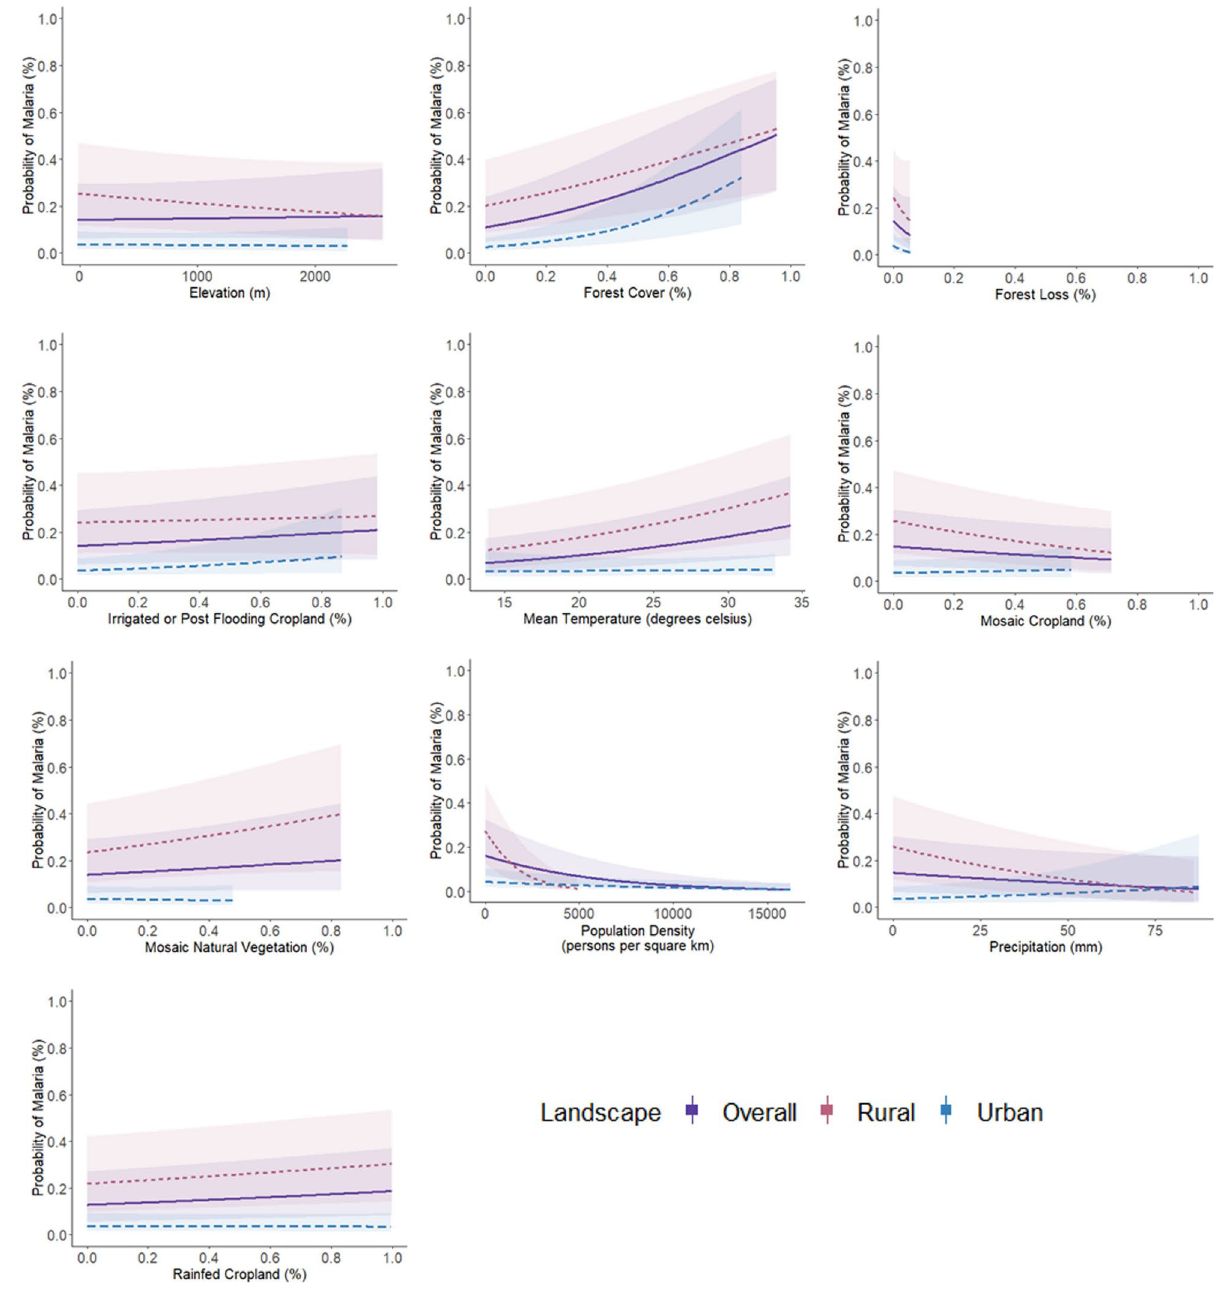
Figure 3. Univariate sensitivity analysis for continuous predictors. Marginal effects curves for continuous predictors included within the global model. This is a univariate sensitivity analysis that generates predictions generated by a model when one holds the non-focal variables constant and varies the focal variable. The global model consists of all variables within our georeferenced dataset and represents the most complex model. Marginal effects measure the instantaneous effect that a change in a particular explanatory variable has on the predicted probability of malaria when the other covariates are kept Univariate sensitivity analysis. The marginal effect of a continuous independent variable (e.g. rainfed cropland) is the instantaneous rate of change (e.g. the change in the probability of malaria) given very small changes (close to zero) in that variable 45 . Here, results suggest that the global model was most sensitive to forest cover and population density with the instantaneous rate of change in the probability of malaria increasing and decreasing substantially for these two predictors, respectively (Fig. 3) (note, here forest cover does not reflect reforestation but rather the static extent of forest cover in the dataset). For the human-modified landscape variables, the probability of malaria steadily increased when small increases were made in rainfed, irrigated or post-flooding cropland and veg-dominated mosaics (Fig. 3). When